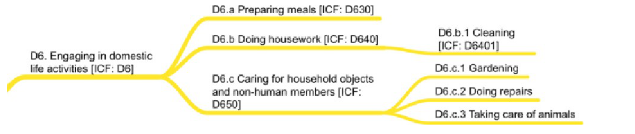
Fig 8. D6 domain on engaging in domestic life activities.